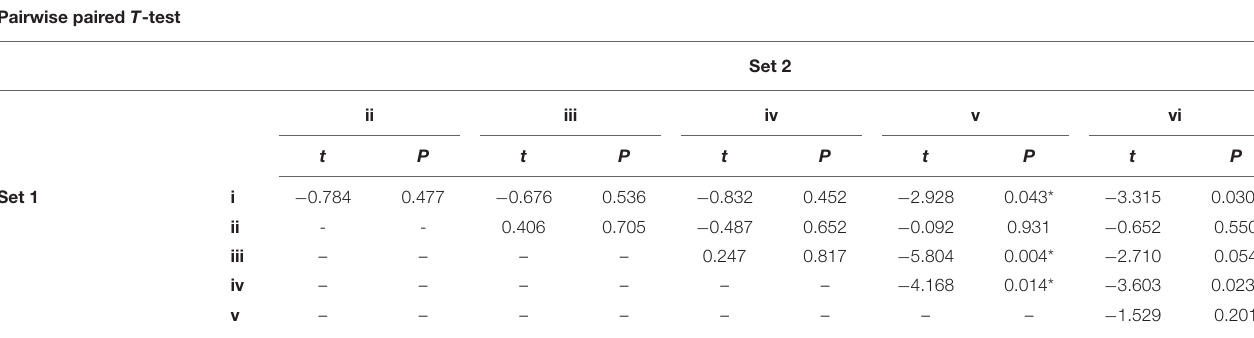
TABLE 2 | Performances comparison with different combinations of multi-omics data by pairwise paired t -test, according to concordance index among 5-folds cross-validation results. Pairwise paired T -test